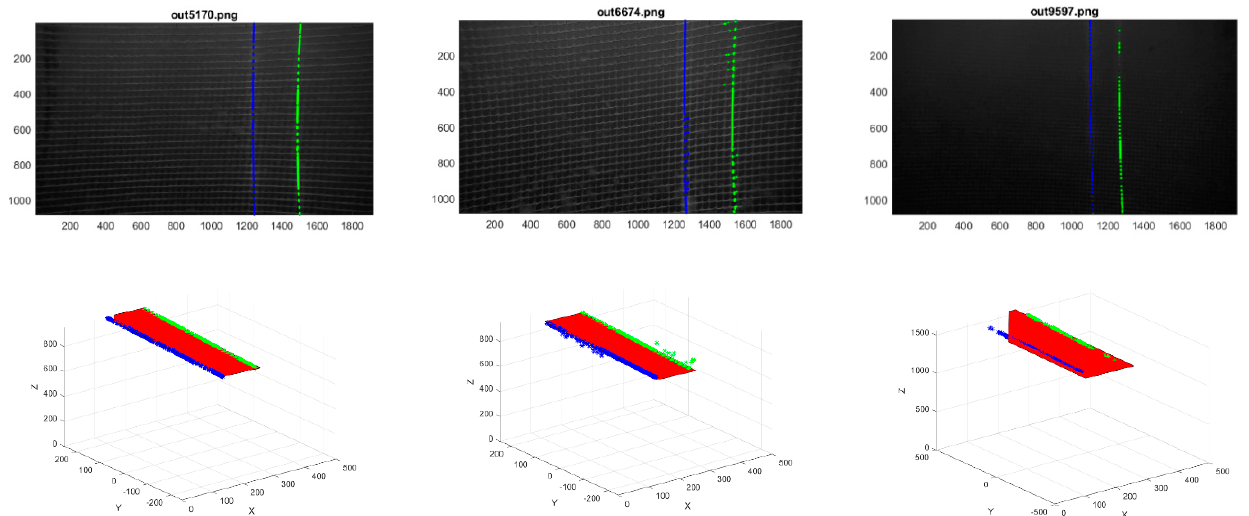
Figure 5. Example of ROV’s laser line images for the camera–laser 3D measurement and the fitted plane representing the net cage wall. Upper row is the images, and lower row the plane fitted to the x,y,z positions of the points; units are in mm.